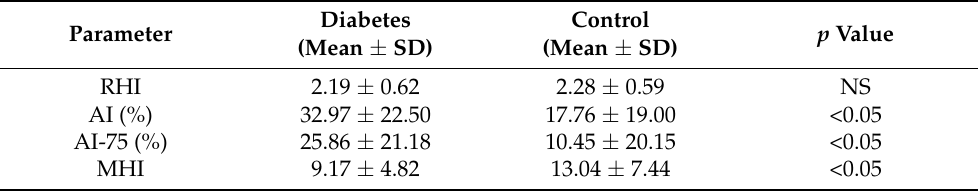
Table 2. Assessment of endothelial function by EndoPAT 2000 and the Laser Doppler Flowmetry.